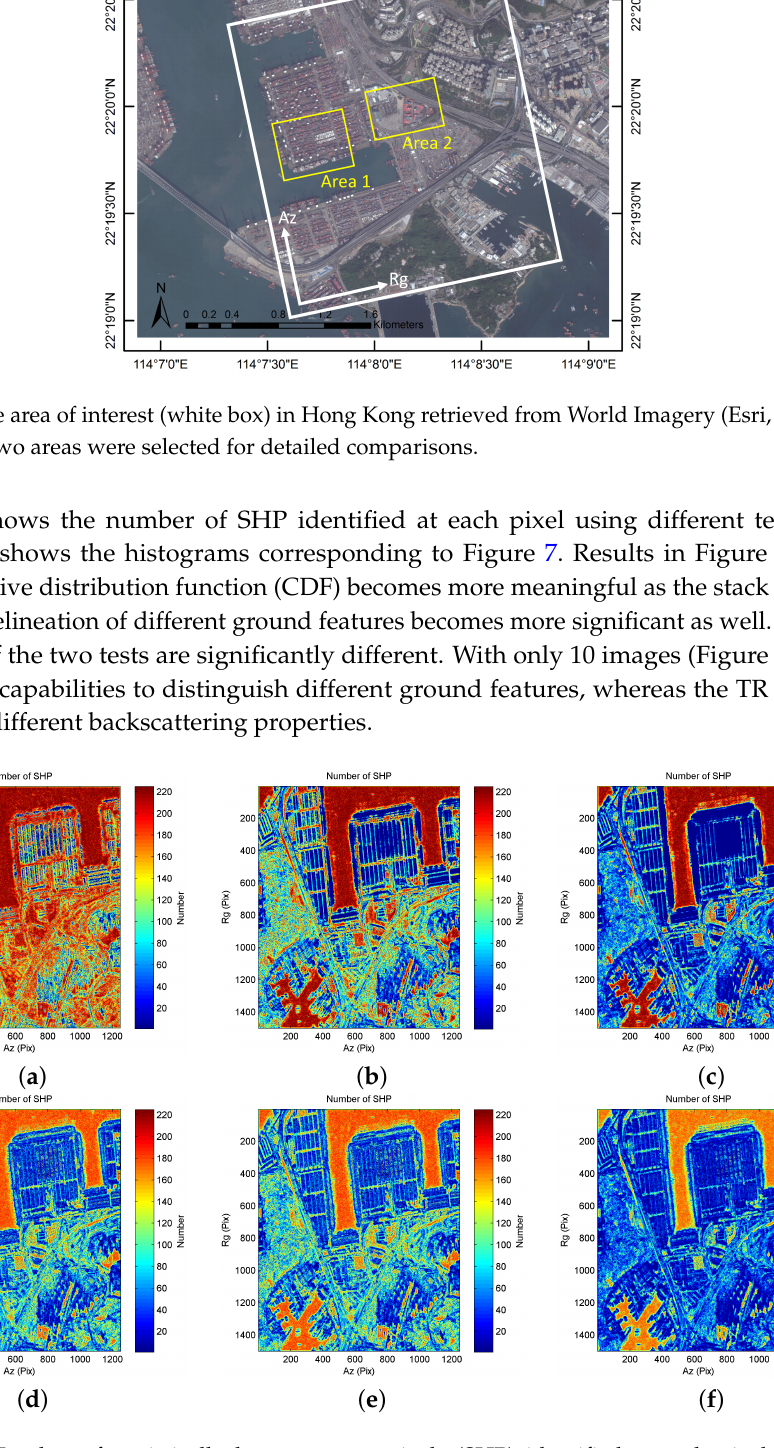
Figure 7. Number of statistically homogeneous pixels (SHP) identified at each pixel based on different tests and stack sizes. The significance level is 5%. ( a – c ) represent the SHP number of the Anderson-Darling (AD) test using 10, 30, 75 images, respectively; ( d – f ) correspond to the SHP number of Robust-T (TR) test using 10, 30, 75 images,